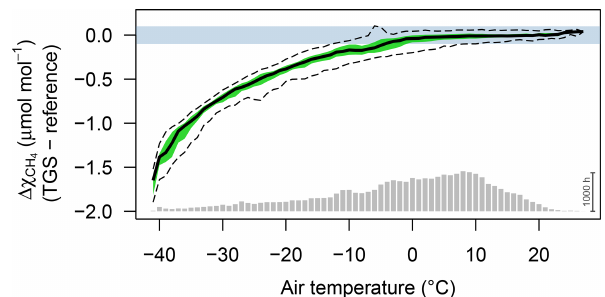
Figure 2. Difference between TGS 2600 and reference CH 4 mea- surements (30min averages) as a function of air temperature when using the Eugster and Kling (2012) conversion. Agreement was good when ambient temperature was above freezing. The horizontal color bar shows the ± 0 . 1µmolmol − 1 range around a perfect agree- ment. The green band shows the interquartile range of bin-averaged differences (TGS 2600 sensor 1), and dashed lines show the extent of the 95% confidence intervals. Gray bars at the bottom show the number of 30min averages in each bin. The scale bar (1000h) on the right specifies their